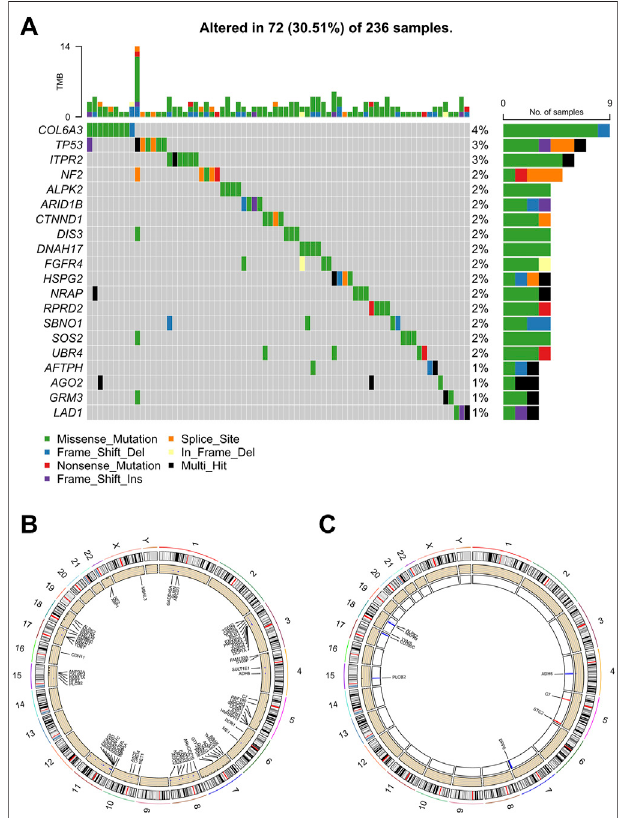
FIGURE 2 | Characteristics of butyrate-metabolism-related genes in ccRCC. (A) Landscape of mutation pro fi les in 236 ccRCC patients from TCGA-KIRC cohort. (B) Location of CNV alteration of the butyrate- metabolism-related genes on chromosomes. (C) Location of CNV alteration of the DEGs on